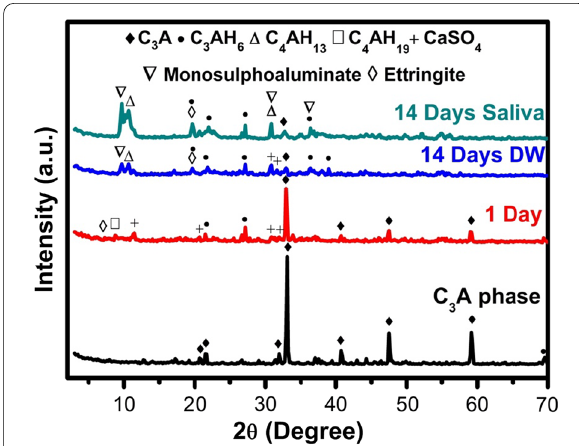
Fig. 3 XRD spectral analysis of the anhydrous C 3 A phase and cured samples under distilled water and saliva solution for 1 and 14 days